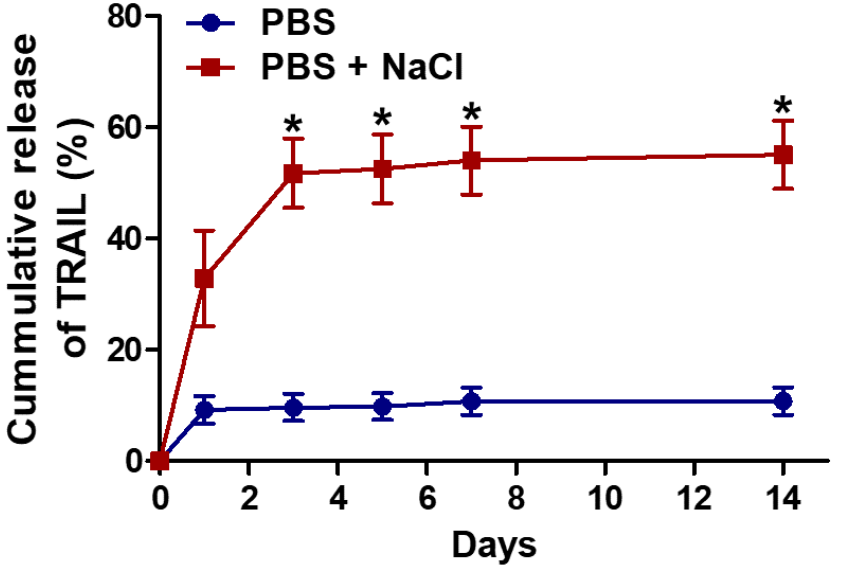
Figure 3. Release profile of TRAIL from mPEG-Coa in PBS (135 mM NaCl) and PBS supplemented with additional NaCl (total 185 mM NaCl). (*) indicates a significant difference as compared with PBS group.